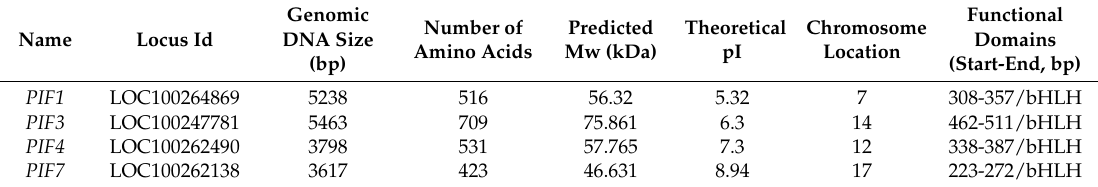
Table 1. Characteristics of Phytochrome-Interacting Factors ( PIFs ) genes.